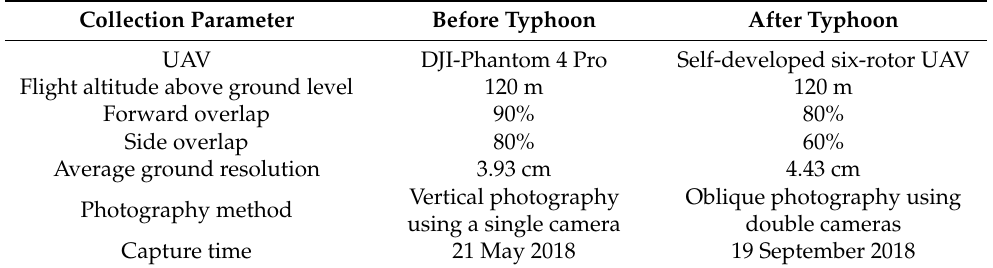
Table 1. The parameters of UAV flight before and after typhoon Mangkhut hit Shenzhen. Collection Parameter Before Typhoon After Typhoon UAV DJI-Phantom 4 Pro Self-developed six-rotor